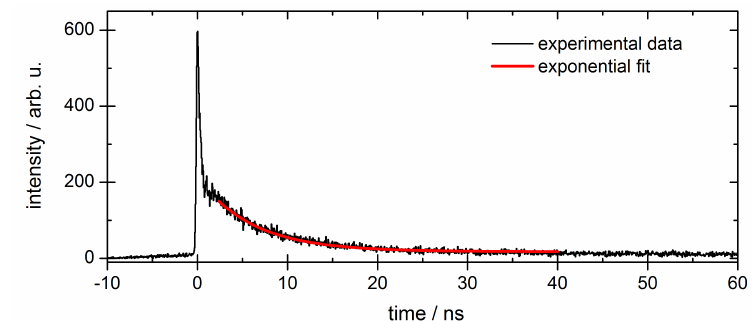
Figure 4. Example for a histogram of event times relative to the exciting synchrotron radiation pulse (set to time zero). The lifetime is given by the decay constant τ in an exponential decay process of the form y = y 0 + A 0 · e − t τ , with offset y 0 and scaling factor A 0 . The example shows the radiative decay in the vacuum ultraviolet range after photoexcitation of the 1s → 3p resonance in neon. The exponential fit yields an integrated lifetime of τ = ( 6.2 ± 0.2 ) ns in this spectral range. The sharp peak at t = 0 appears due to detection of scattered synchrotron radiation and is therefore excluded from the